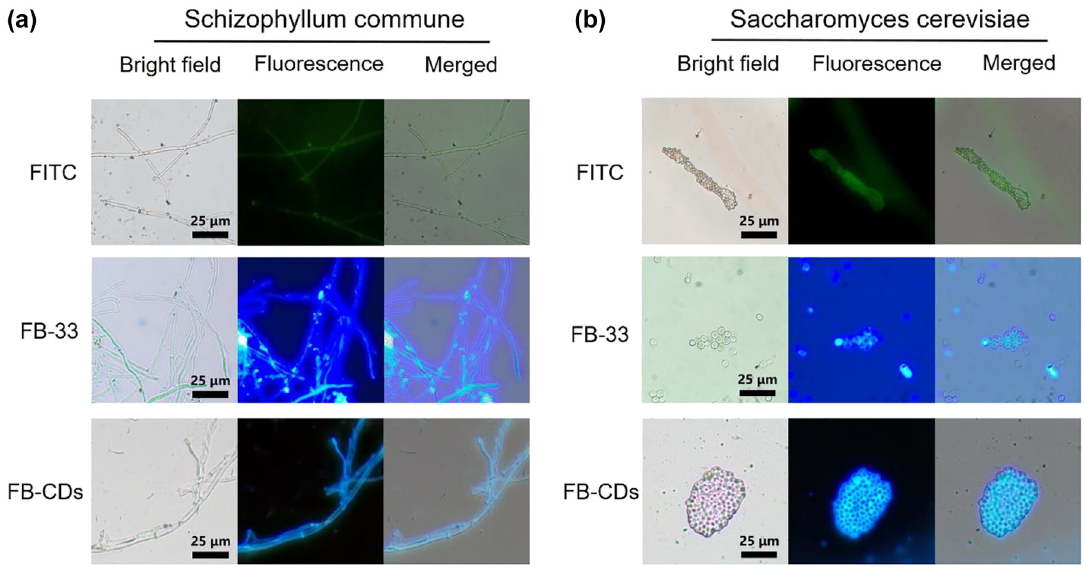
Figure 6: Ultrafast fluorescence imaging based on FB-CDs. Fluorescence images of (a) S. commune and (b) S . cerevisiae treated with FITC, FB-33 and FB-CDs at the same concentration (100 μ g/mL) for 30 s.